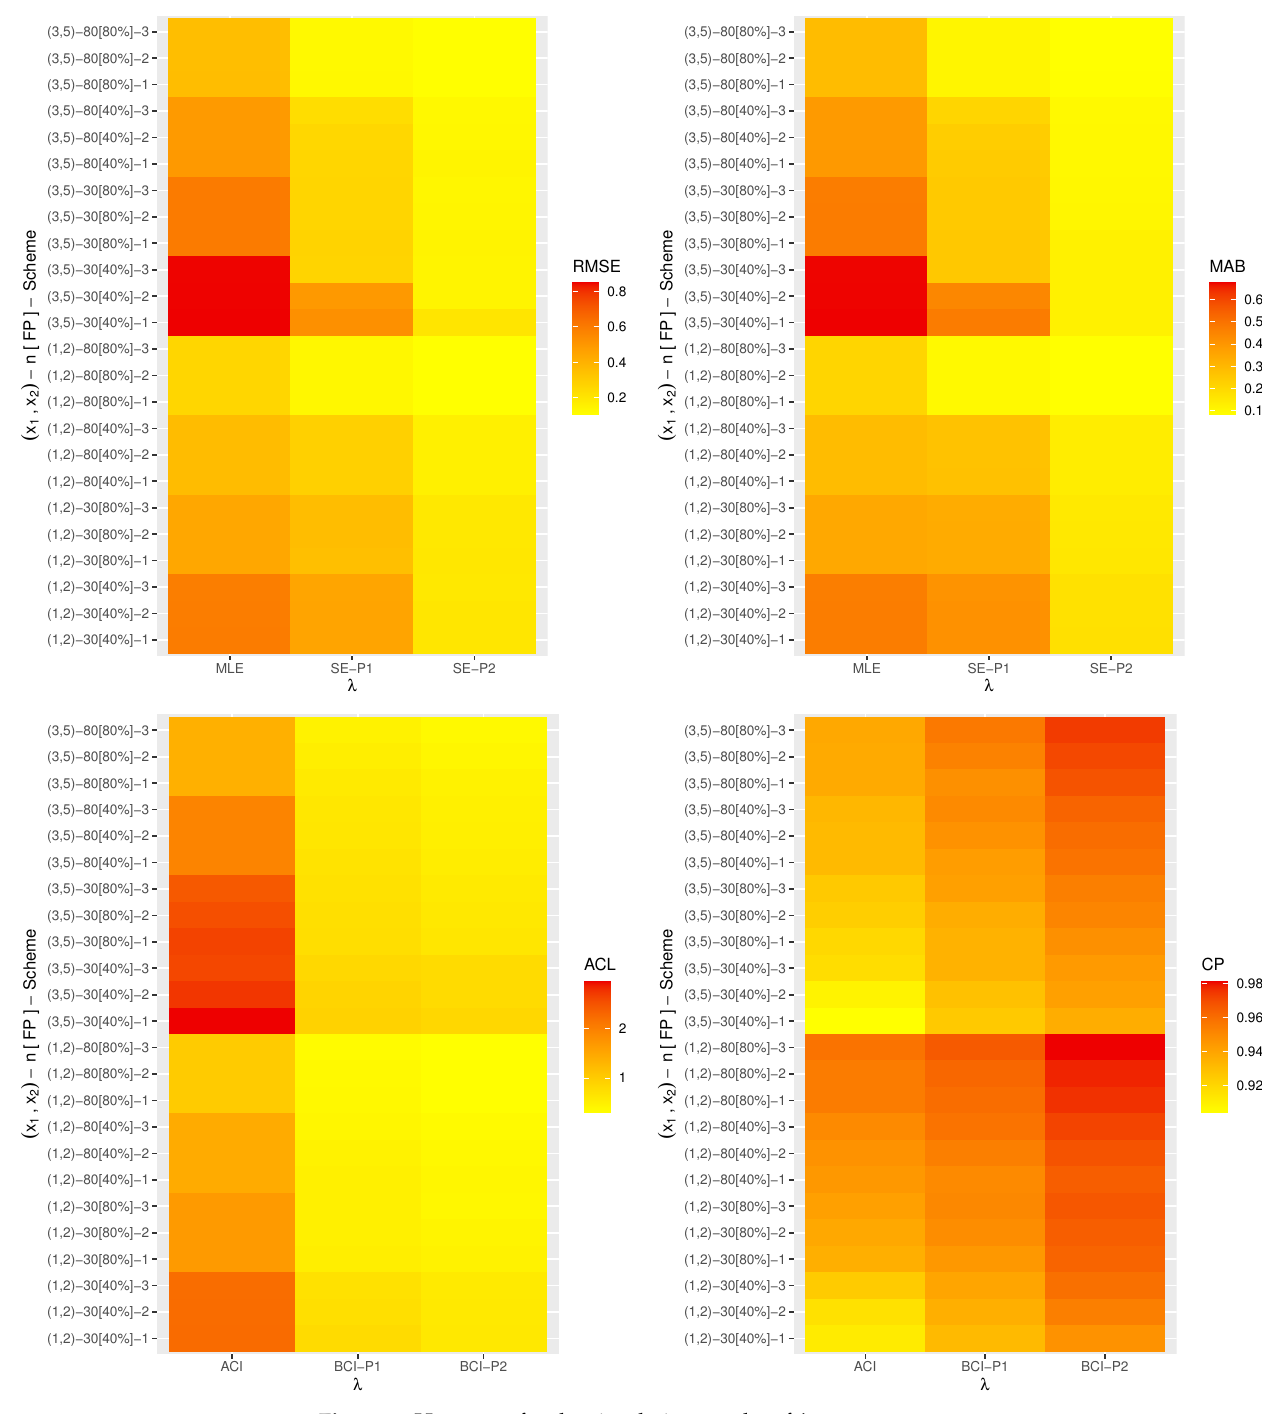
Figure 2. Heat map for the simulation results of λ